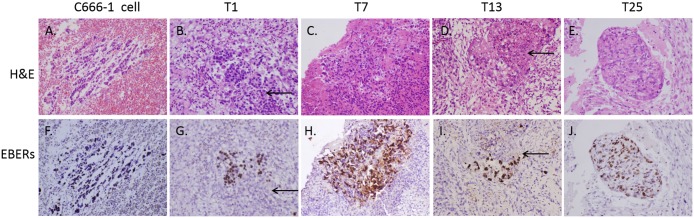
H&E staining and in situ hybridization (ISH).H&E staining and in situ hybridization detection of Epstein-Barr virus–encoded RNAs (EBERs) on CAMs inoculated with C666-1 cells (A and F) or NPC tumor biopsies (B-E and G-J). Arrows point to tumor areas where malignant NPC cells have become EBER negative. Magnification, ×400.